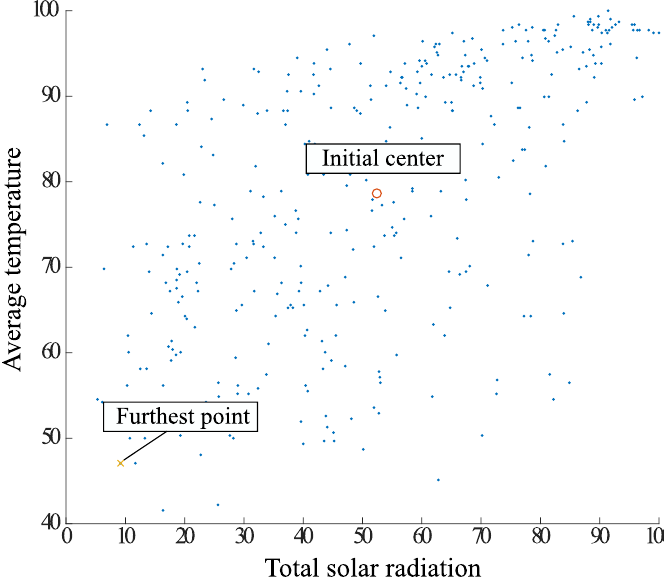
Figure 15. Step 2 and 3 result (Futher